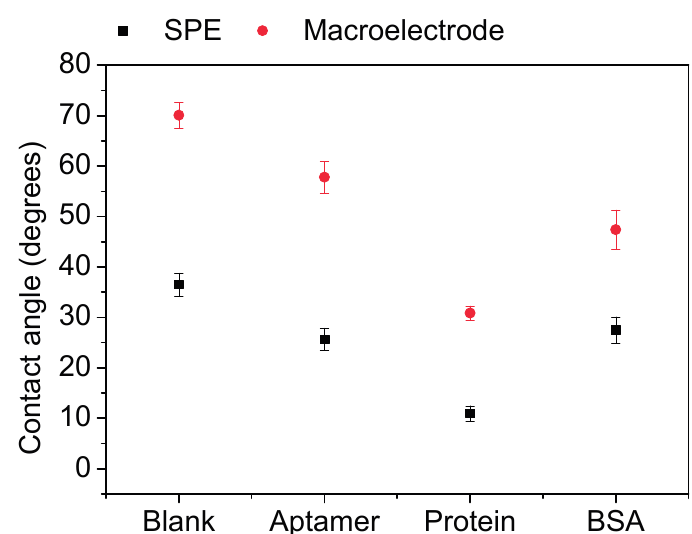
Figure 2. Contact angle values measured for screen-printed electrodes (SPEs) and polished gold surfaces on the different steps of aptasensor construction. All measurements were repeated on three separate